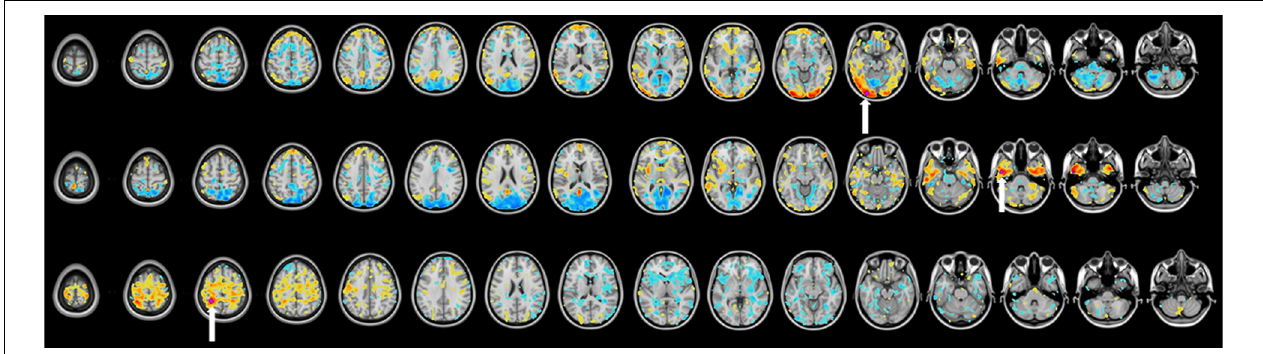
FIGURE 1 | Seed-based correlation map of a single patient with 3 representative ROIs (regions of interest) belonging to different RSNs (resting-state networks) projected onto a reference T1-weighted MRI. The purple dot (labeled with a white arrow) represents the seed ROI and warmer-colored regions represent positive correlation. Cooler colors represent negative correlation. 150 contralesional ROIs were isolated for